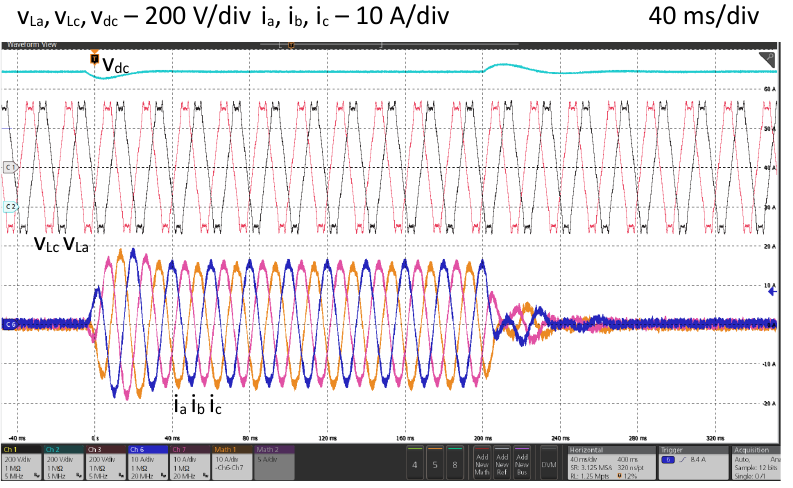
Figure 17. Experimental results of a transient state in the case of DC-link load change.